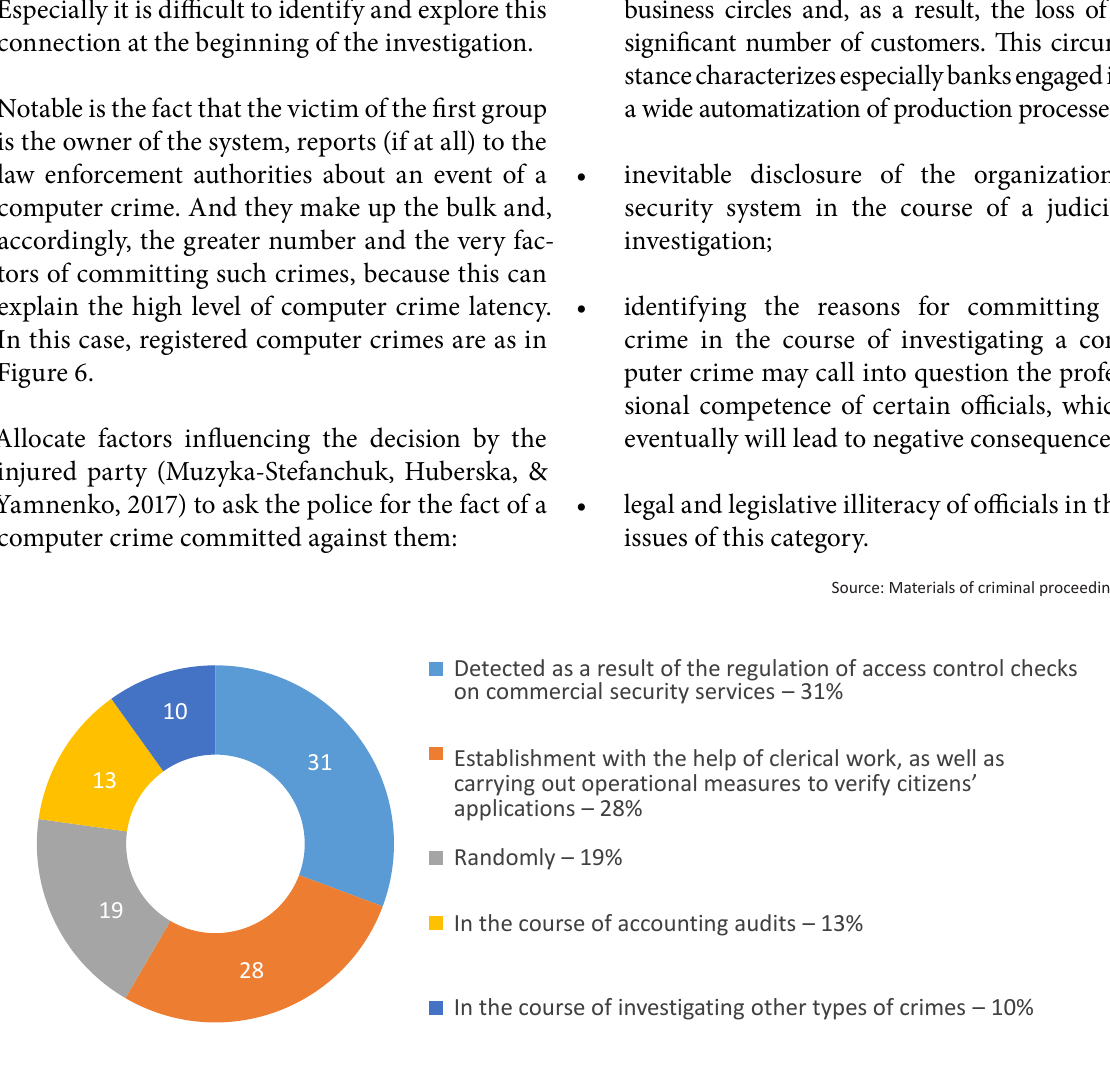
Figure 6. Ways of detecting the fact of committing computer